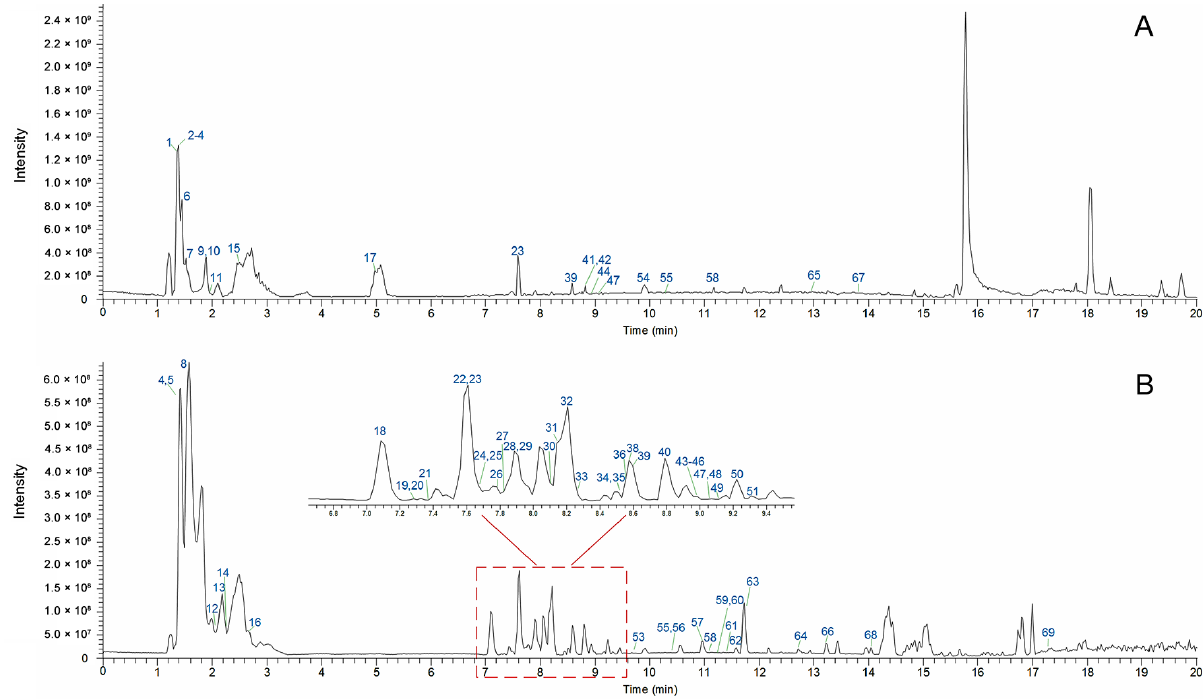
Figure 1. Base peak chromatograms of RS in positive ionization mode ( A ) and negative ionization mode ( B ).